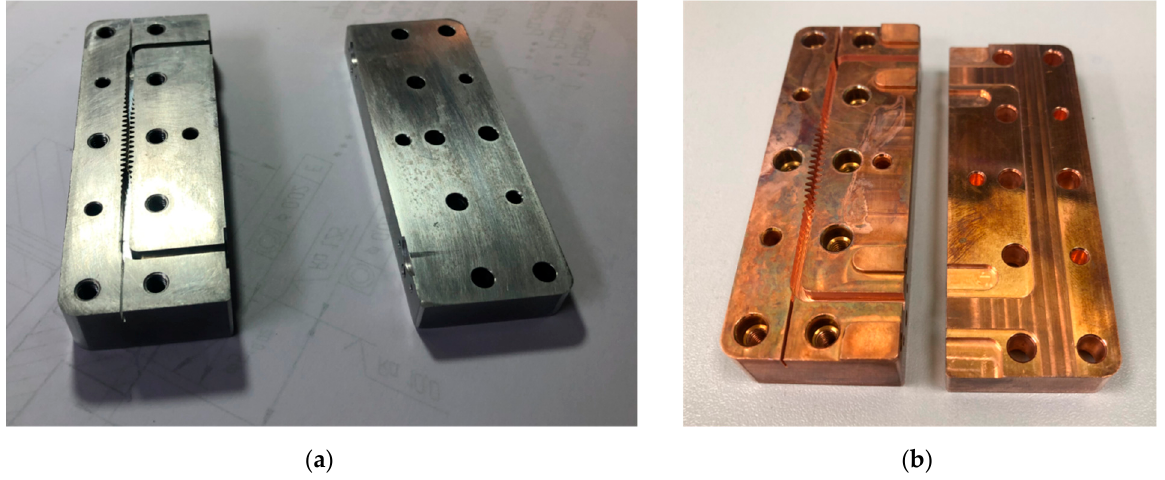
Figure 3. Photos of the fabricated by CNC micromilling samples of the proposed interaction struc ‐ ture: ( a ) an aluminum ‐ made interaction structure; ( b ) the final sample of the interaction structure made from oxygen ‐ free copper.